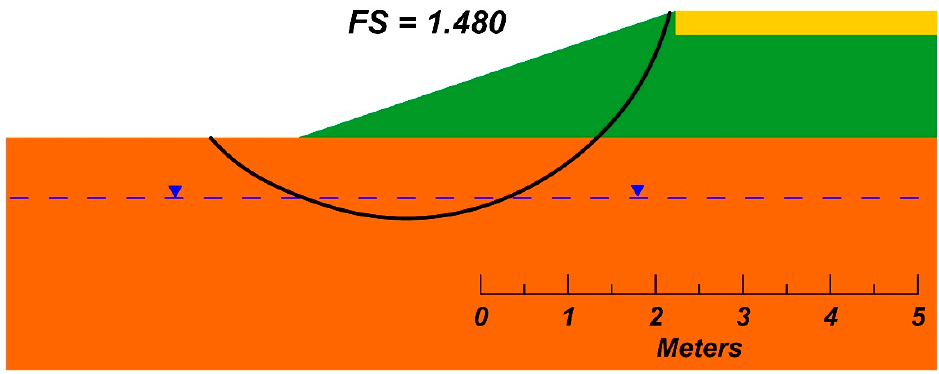
Figure 14. Critical slip surface for the back-analyzed shear strength by the linear envelope with suc-